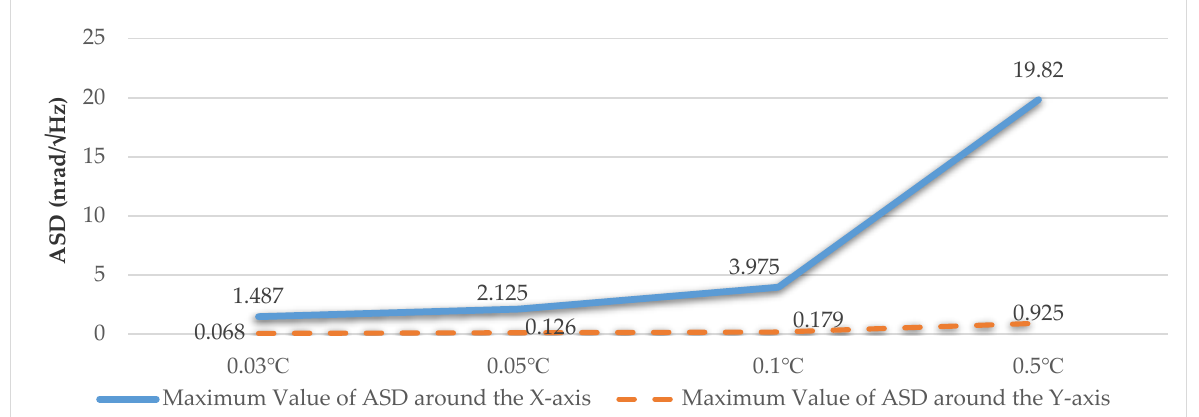
Maximum Value of ASD around the X-axis Maximum Value of ASD around the Y-axis Figure 6. Amplitude spectral density under different temperature variations.